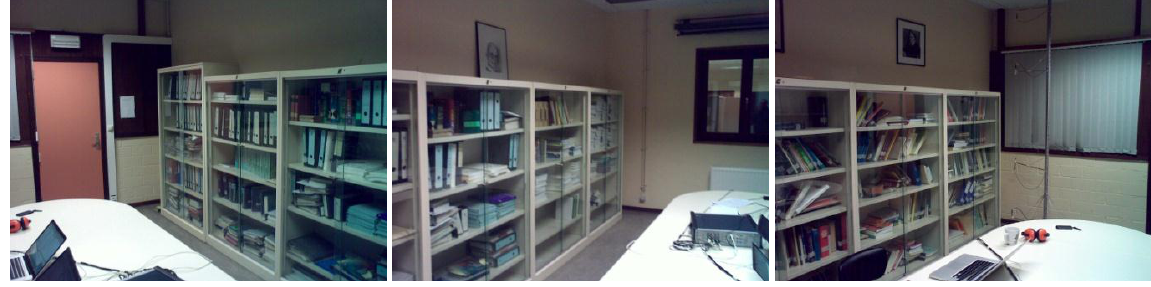
Fig. 2. Acoustic system: Library.